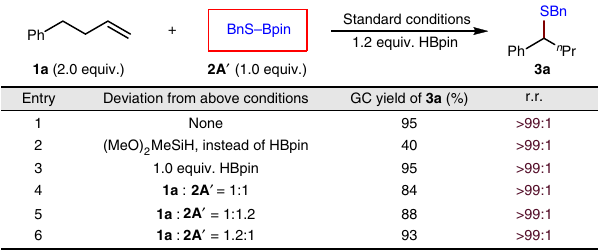
e 11 B NMR tracing experiments of the standard reaction